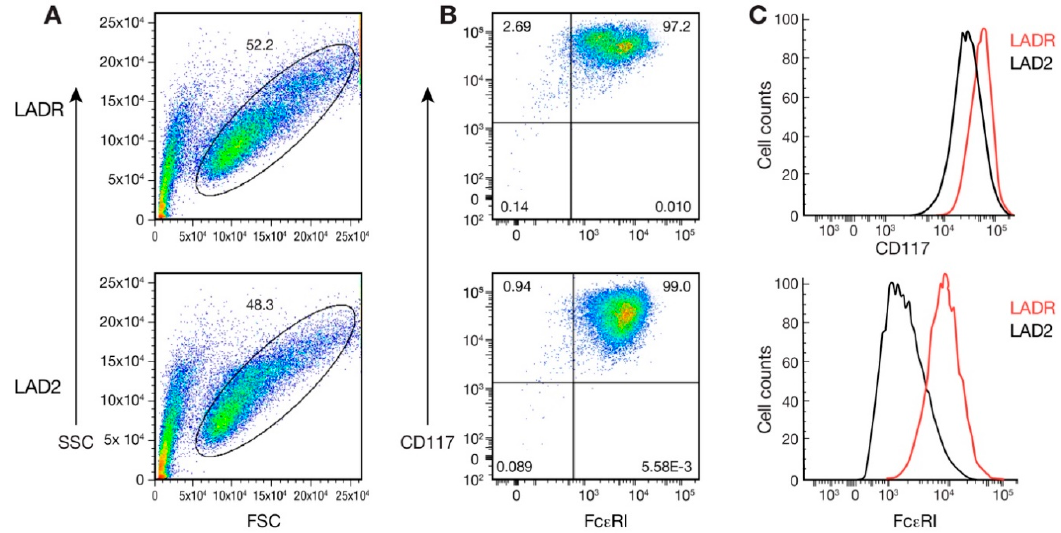
Figure 2. Flow cytometry studies comparing LADR with LAD2 cells. ( A ) LADR cells (upper panel) are larger (based on FSC, horizontal axis) and more granulated (based on SSC, vertical axis) when compared with LAD2 cells (lower panel). ( B ) LADR cells (upper panel) have higher expression of Fc ε RI (horizontal axis) and CD117 (vertical axis) when compared with LAD2 cells (lower panel), and ( C ) histograms of CD117 (upper panel) and Fc ε RI (lower panel) expression comparing LADR (in red) and LAD2 cells (in black) and consistent with results in B. Table 1. Surface expression of CD markers. LADR cells expressed CD13, CD33, CD34, CD63, CD117, CD123, CD133, CD184, CD193, and CD195, while LAD2 cells expressed CD33, CD34, CD63, CD117,